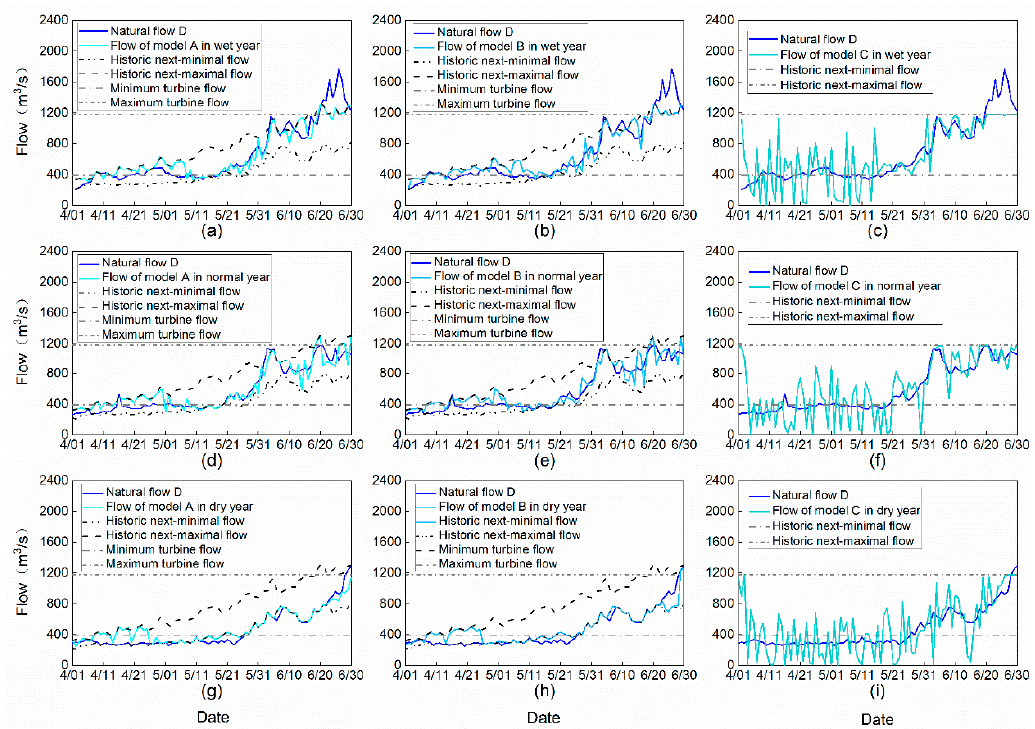
Figure 5. Optimum flow processes corresponding to different models in different hydrological representative years, where (a) (b) (c) stands for model A, model B, and model C in the wet year (2011), respectively; (d) (e) (f) stands for model A, model B, and model C in the normal year (2014), respectively; (g) (h) (i) stands for model A, model B, and model C in the dry year (2015), respectively.